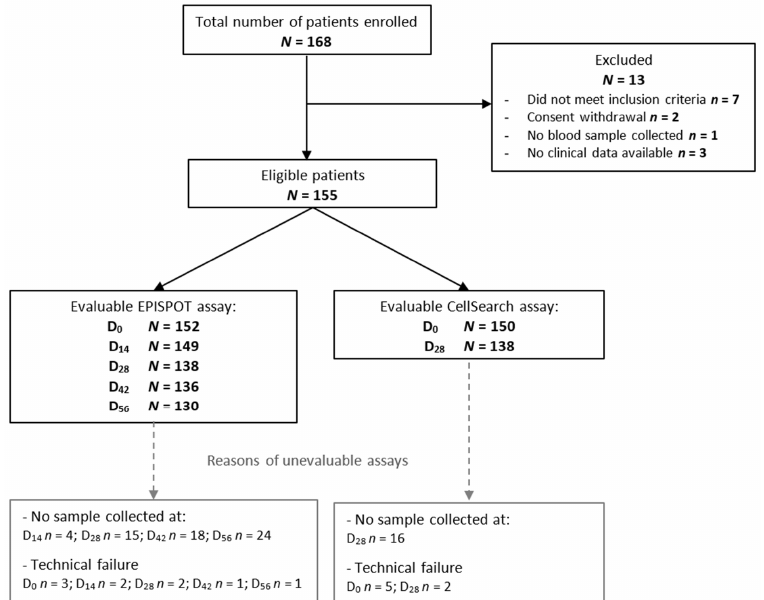
Figure 1. Study flowchart showing the number of included patients and the number of patients in whom CTCs could be assessed in peripheral blood samples at different time points before (D 0 ) and during treatment (EPISPOT: D 14 , D 28 , D 42 , D 56 ; CellSearch ® : D 28 ). Abbreviations: N, number; D, day.